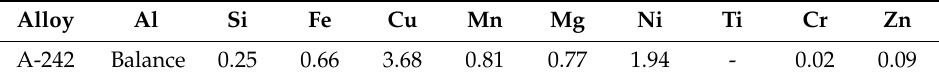
Table 3. Chemical composition of the A-242 aluminium alloy obtained after the melting and composition adjustment steps.